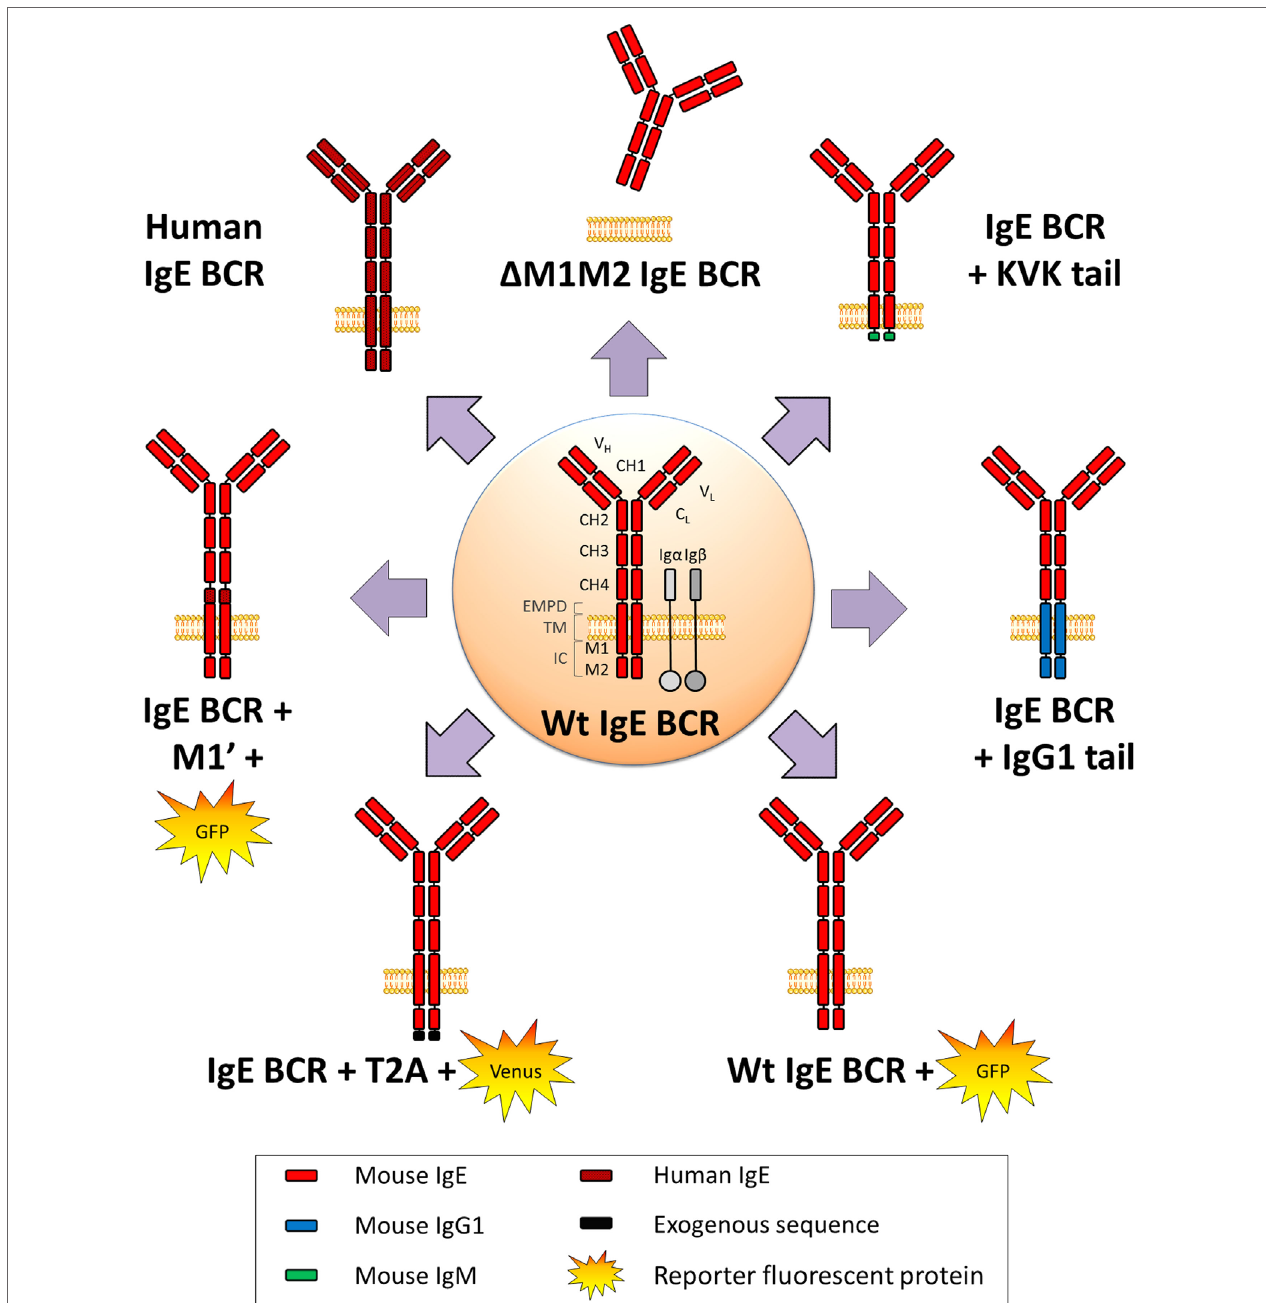
FigURe 3 | WT and variant IgE B cell receptor (BCR) expressed in mouse models. Mouse WT IgE BCR structure is schematized in the center. Heavy and light chain variable (VH and VL) domains form the antigen-binding site, constant domains (CH), transmembrane (TM), and intracellular domains (IC) are shown, and anchored in the lipid membrane. IgE BCR includes an extra-membrane proximal domain (EMPD). Co-signaling molecules Ig α and Ig β are represented in gray. Variant and chimeric IgE BCR resulting from the different knock-in and knock-out alleles (described in Figure 2 ) are represented, and reporter fluorescent proteins are